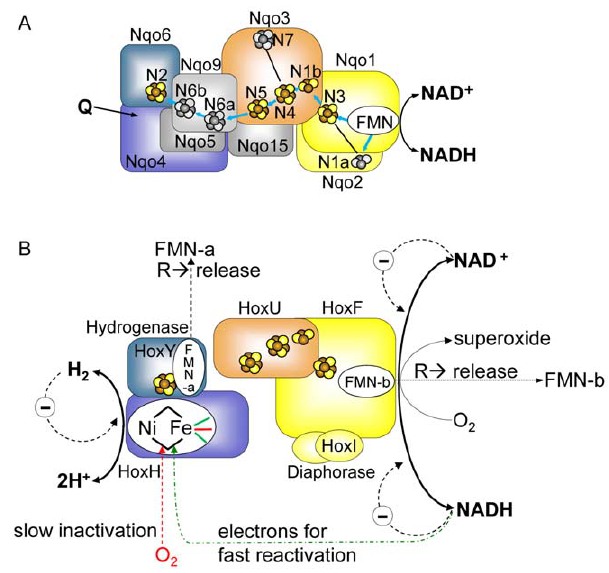
Figure 1. Modular structure and proposed cofactor arrange- ment and function of the soluble NAD + -reducing [NiFe]- hydrogenase of R.eutropha based on the results of the present study and references [ 7,15,16,21,51 ] . Panel A displays the cofactors of the hydrophilic part of T. thermophilus Complex I [14]. Orthologous subunits of Complex I and SH carry the same colours. Iron- sulfur clusters, which are conserved in the SH, are colored in yellow/ brown, those which are not present in the SH are shown in grey. The proposed electron transfer chain in Complex I is indicated by blue arrows. The N2 cluster localized in the Nqo6 subunit of Complex I corresponds to the iron-sulfur cluster in the hydrogenase small subunit HoxY (see Figs. S1,S2,S3). The proposed quinone-binding site (Q), which is situated in Nqo4, is indicated by an arrow [17]. Panel B shows the current SH model, the proposed localization of the individual cofactors and reactions taking place at the SH. The CN 2 ligands and the CO ligand of the Ni-Fe active site iron are shown in green and red, respectively. For sake of clarity, the hydrogenase and diaphorase modules are drawn separately. Main physiological reactions are shown in bold lines and fonts. ‘‘R’’ stands for ‘‘under reducing conditions’’, ‘‘ H ’’ for ‘‘product inhibition’’. Dashed lines represent effects, but without information of effect location. NADH-derived electrons for fast reactivation of the oxidized active site are passed through the FMN cofactors and the FeS clusters. For details see text and references [7,15,16,21,51].